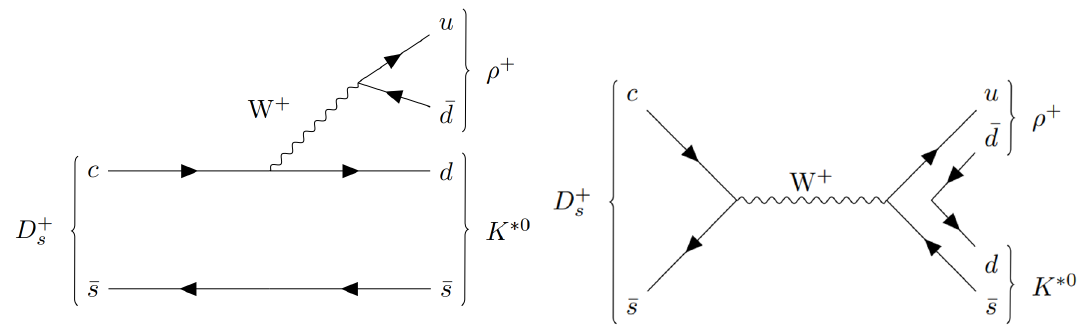
Figure 1 . The T -diagrams (left) and A -diagrams (right) for the decay D +